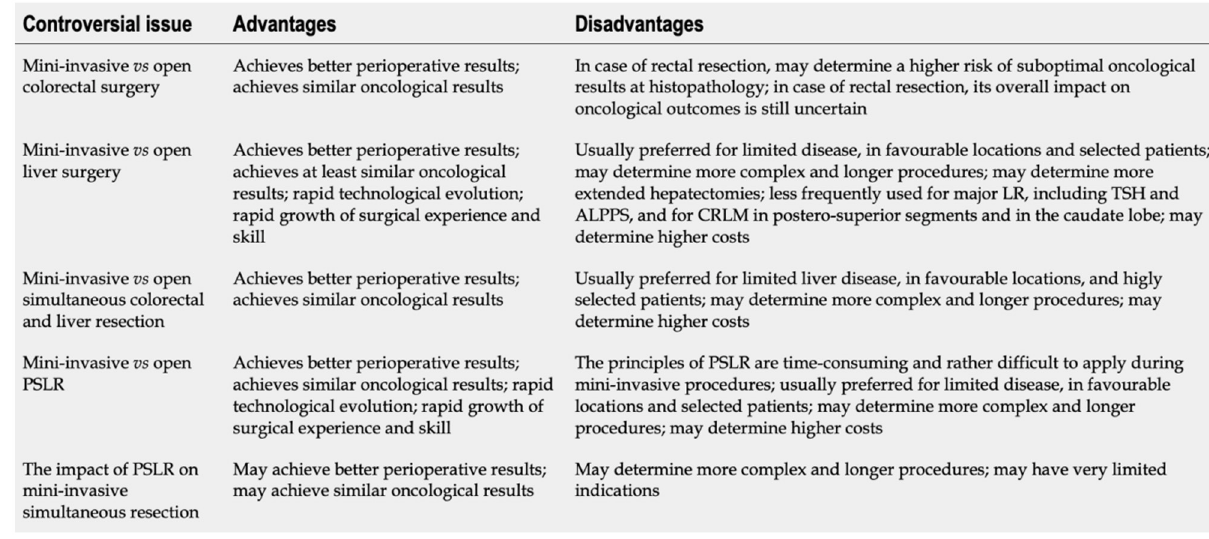
FIGURE 5 | Controversial issues involving mini-invasive (laparoscopic and robotic) surgical strategies for colorectal cancer with synchronous resectable liver metastases. LR, Liver resection; TSH, Two-stage hepatectomy; ALPPS, Associating liver partition and portal vein ligation for staged hepatectomy; CRLM, Colorectal liver metastases; PSLR, Parenchymal-sparing liver resection. From De Raffele et al. (